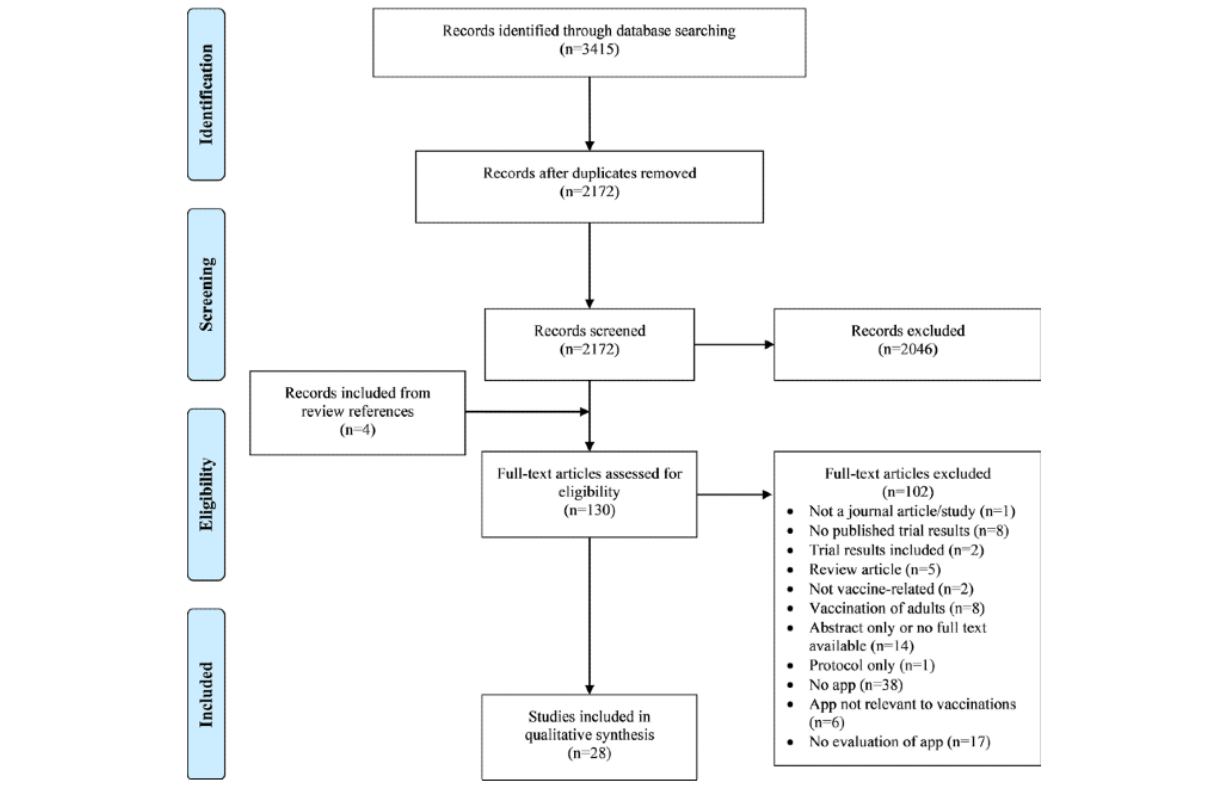
Figure 1. Preferred Reporting Items for Systematic Reviews and Meta-Analyses flow diagram of study